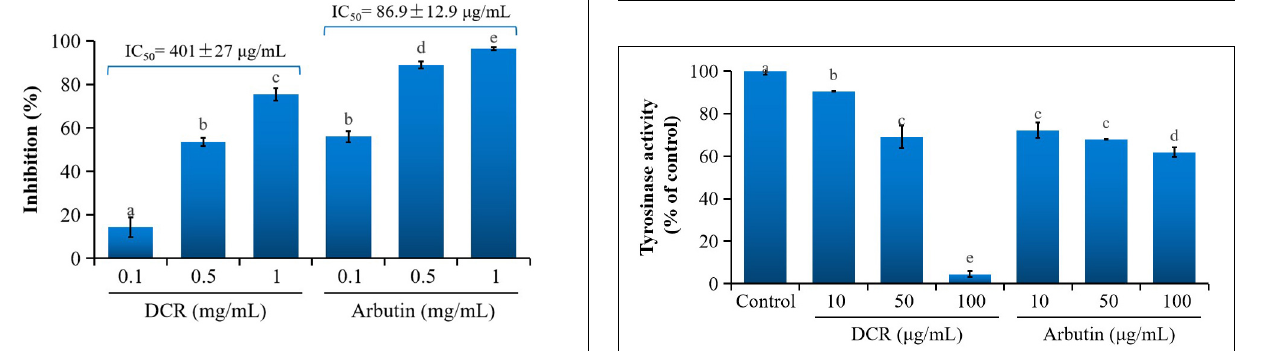
FIGURE 3 | The effect of Dryopteris crassirhizoma rhizome (DCR) on the tyrosinase activity of zebrafish embryos. Different lower case letters indicate significant differences ( p <